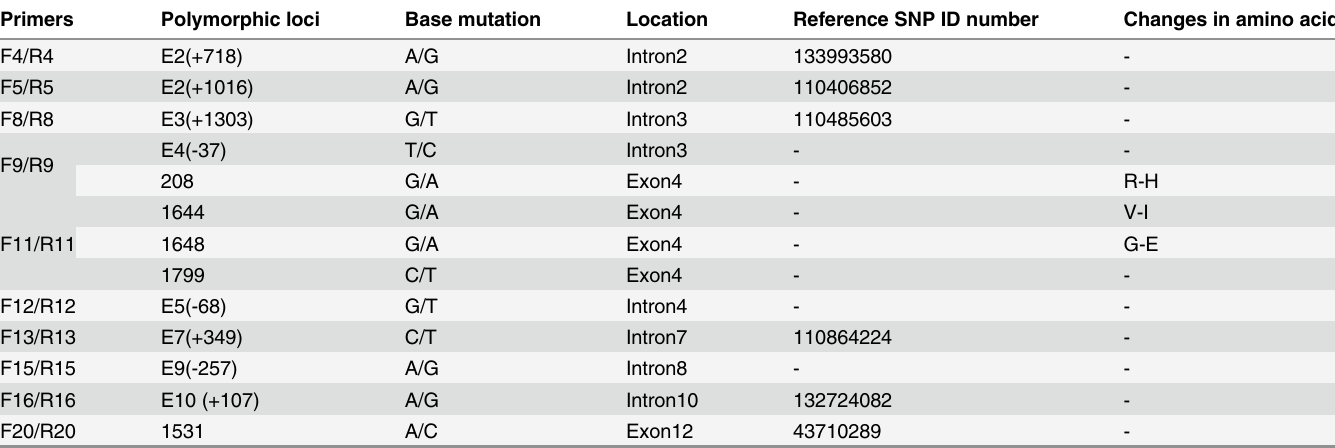
Table 1. Single nucleotide polymorphisms (SNP) in the CARD15 gene of Holstein cattle.